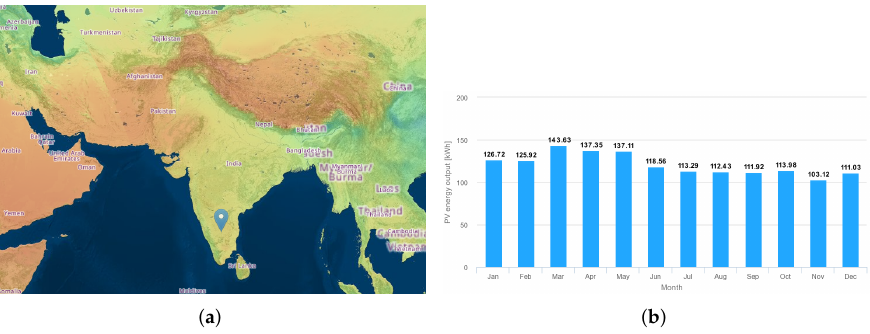
Figure 13. PV energy generation (kWh). ( a ) Map of selected location for the analysis (Bangalore-12.9716° N, 77.5946° E). ( b ) PV energy generation (kWh) at Bangalore, India throughout the